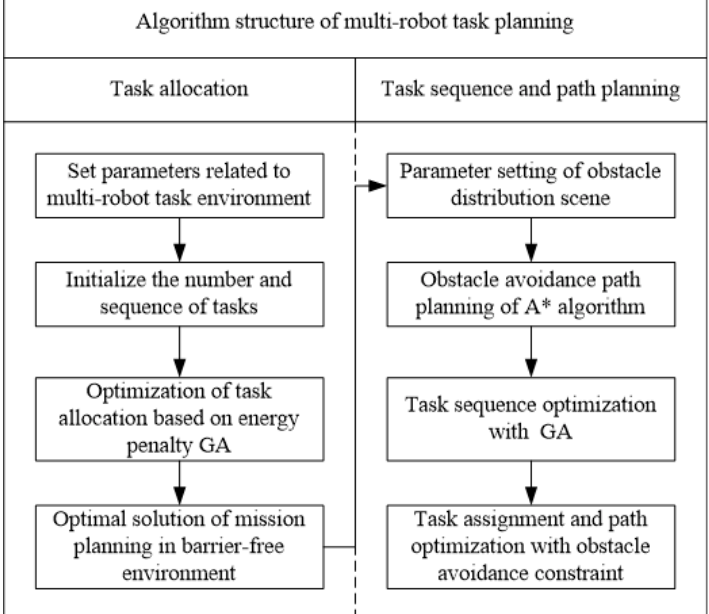
Figure 1. Task planning algorithm framework based on energy penalty.